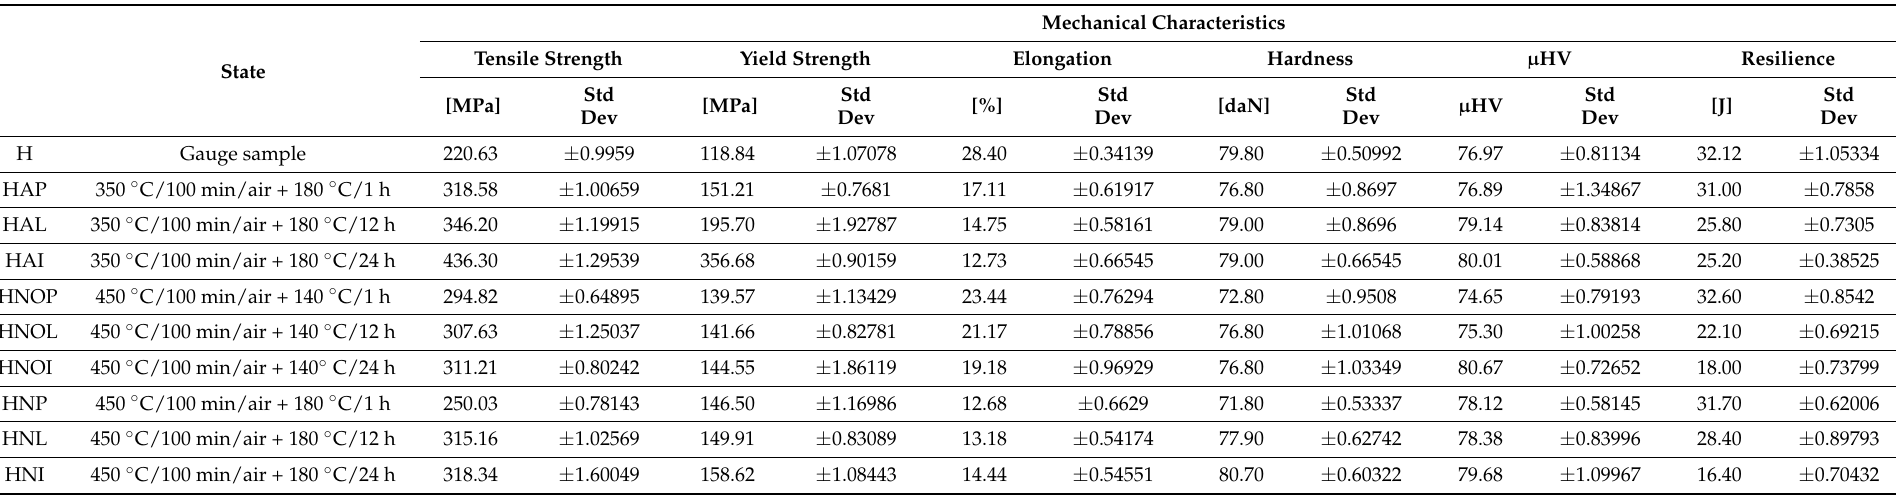
Table 2. Mechanical behavior and grain size of the experimental samples type 5083 in different structural